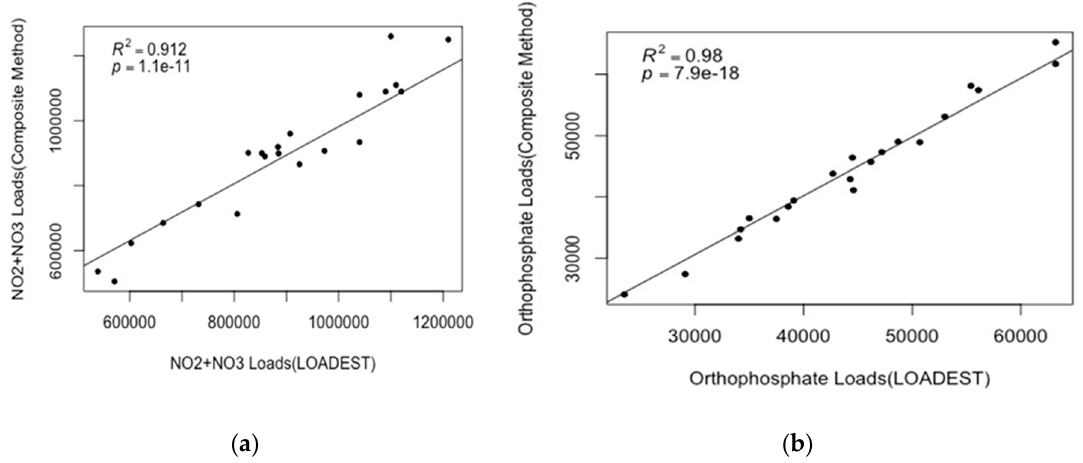
Figure 2. Comparison of the annual nutrient loads estimated by the LOADEST and composite methods for ( a ) NO 2 − + NO 3 − and ( b ) orthophosphate during the period of 1996–2016.